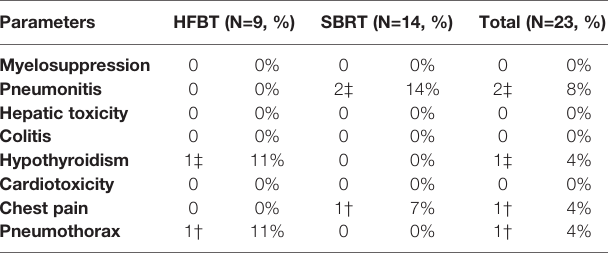
TABLE 2 | HFRT and nivolumab treatment-related